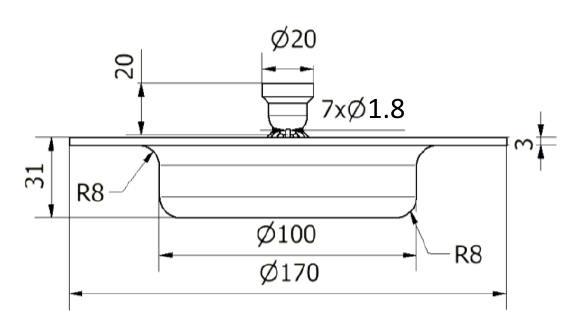
Fig. 1. Model of the engine combustion chamber powered by natural gas used for testing